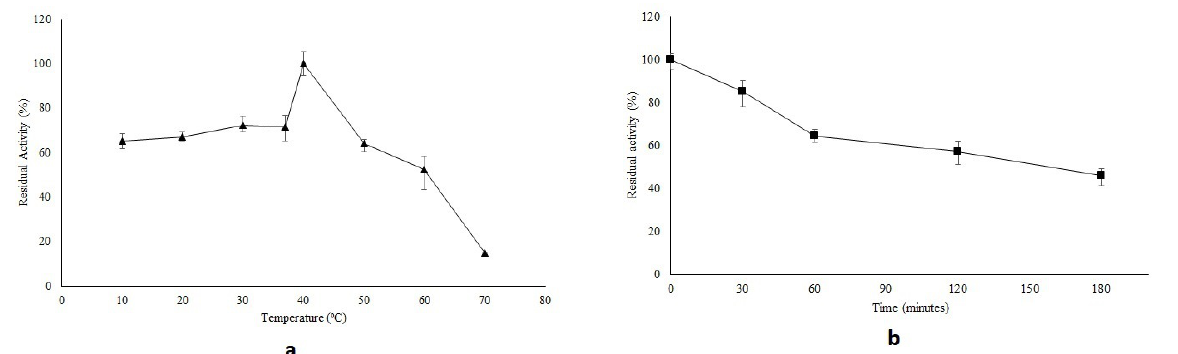
Figure 4. a - Effect of temperature on enzyme activity. b - Stability of enzyme activity at 40ºC.